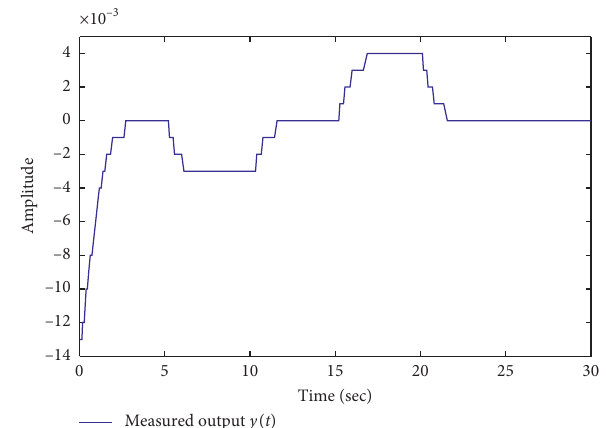
Figure 5: Response of the quantized measured output y ( t ) for case-II.